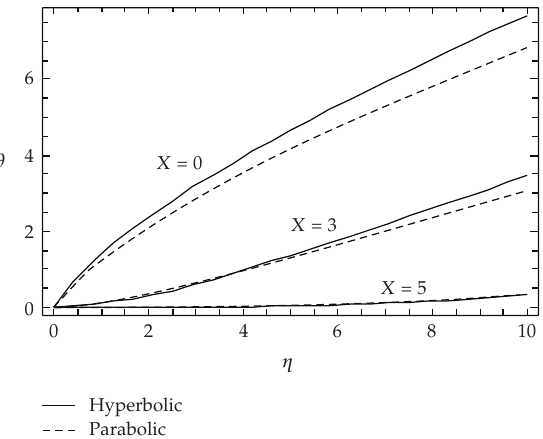
Figure 1: Dimensionless temperature distributions resulting from the hyperbolic and parabolic models with dimensionless velocity of the medium for the heat source of constant strength; φ (cid:3) η (cid:4) (cid:5) 1 , ψ 1 , and β (cid:5) 1 ,η (cid:5) 3 .